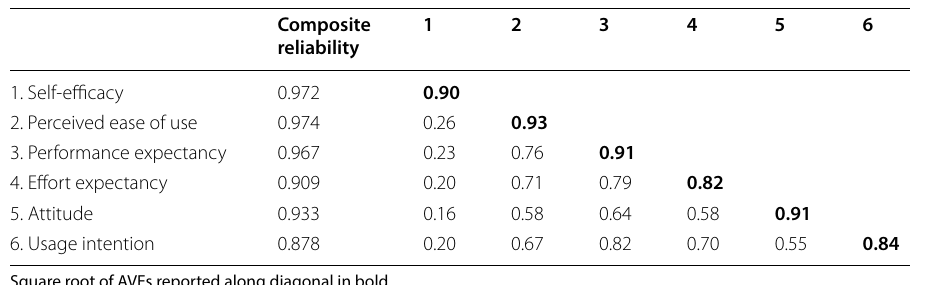
Table 4 The correlation between variables